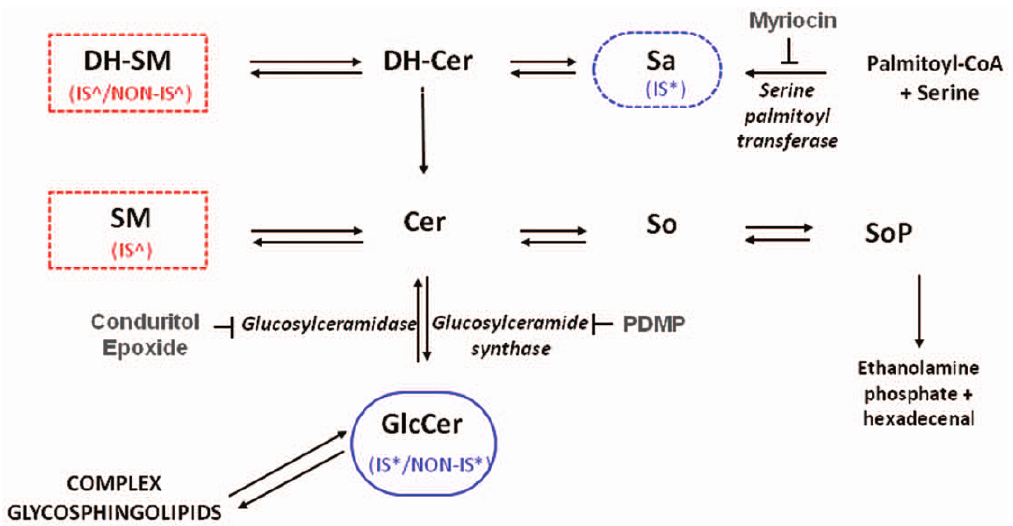
Figure 4. Schematic diagram of the sphingolipid metabolic pathway showing age-related molar fractional changes found in CD4 + T cell non-IS and IS fractions. Cer is considered the central hub of sphingolipid metabolism [3]. It is synthesized de novo in the endoplasmic reticulum by the condensation of serine and palmitoyl-CoA to form 3-keto-sphinganine (not shown), which is reduced to Sa. Sa is then N-acylated by a series of Cer synthase enzymes that display some selectivity towards particular fatty acyl chain lengths. The enzyme desaturase converts these DH- Cer into Cer, which are then transported to the Golgi apparatus. At this cellular subsite, Cer can be converted into a variety of interconnected sphingolipid products. Cer can be glycosylated to form Glc-Cer, followed by transformation into more complex GSL. Alternatively, Cer can be converted into SM, or follow a degradative pathway leading to So and SoP. The enzymes catalyzing these conversions are shown in italics, and the specificity of the three inhibitors used in the study (myriocin, CBE and PDMP) are illustrated. Sphingolipids that displayed significant (* p , 0.05) age- related differences in their relative abundance in both the non-IS and IS fractions have a solid boundary. Sphingolipids that displayed a significant (* p , 0.05) age-related difference or a trend ( ‘ p , 0.1) in at least one fraction have a dashed line. Legends (IS/NON-IS) indicate in which fraction(s) the difference was found. Blue indicates higher in young; red indicates higher in old.